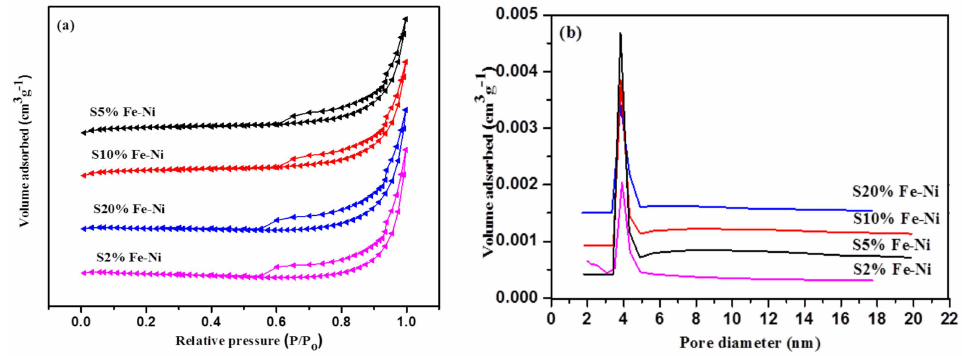
Figure 3. ( a ) N 2 adsorption–desorption isotherms; and ( b ) Pore-size distribution curves for the different percentages of the Fe-Ni